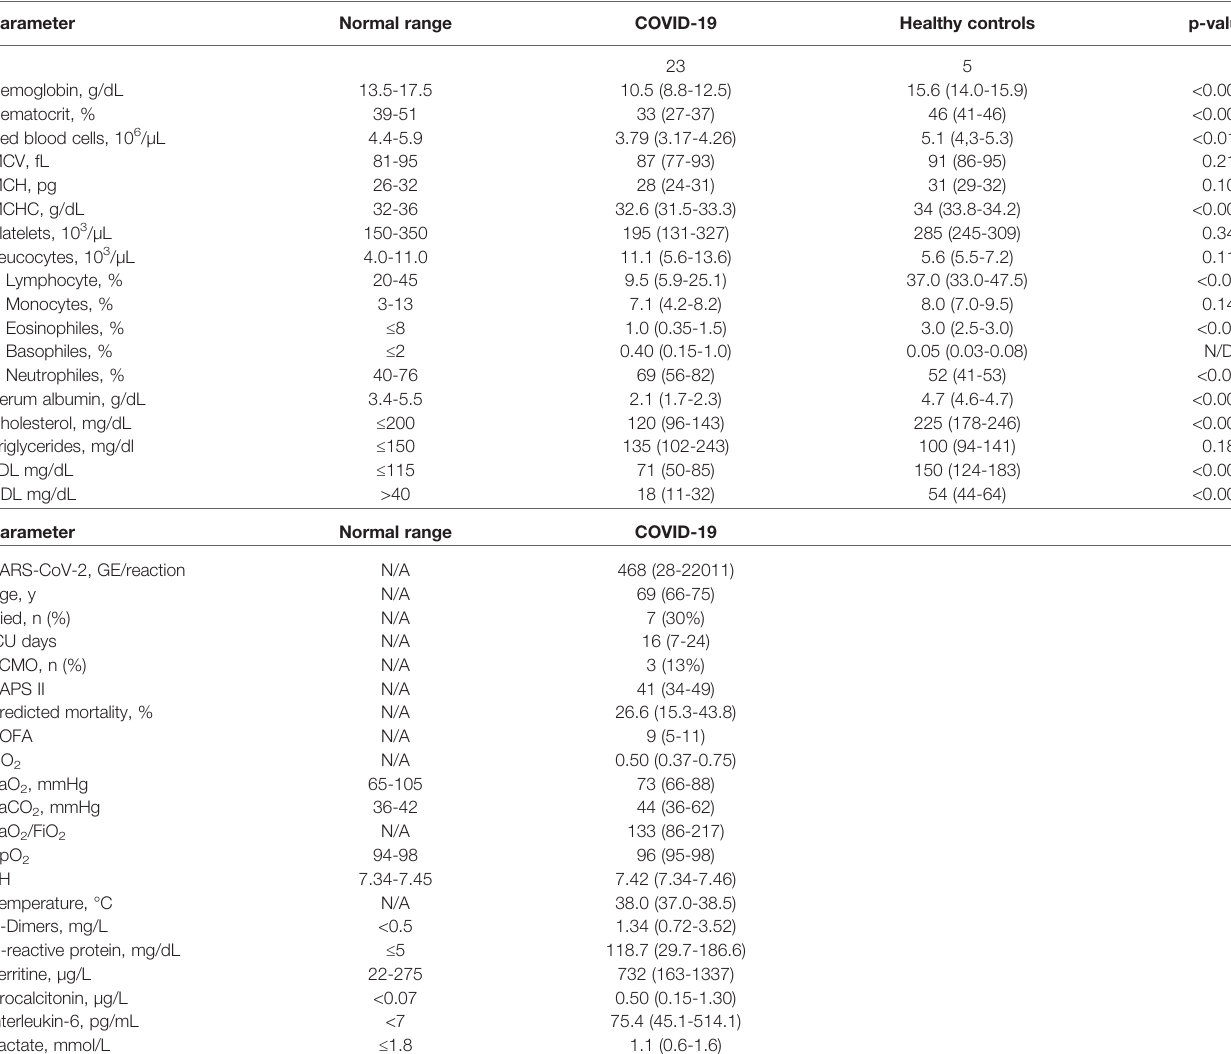
TABLE 1 | Socio-demographic and clinical parameters of patients and healthy